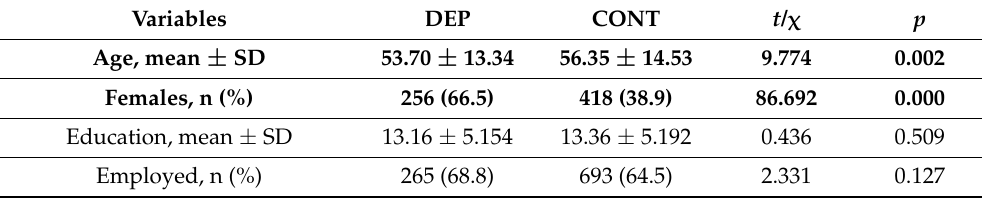
Table 1. Sociodemographic characteristics and data regarding psychiatric evaluation.